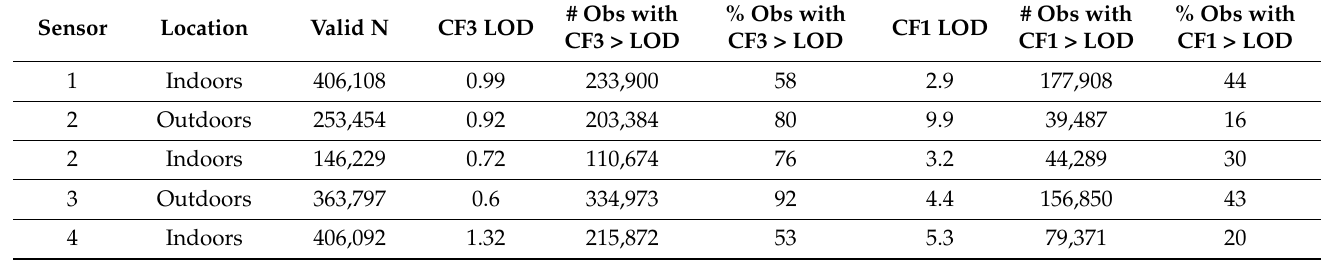
Table 4. PM 2.5 LODs ( µ g/m 3 ) calculated for the ALT-CF3 and Plantower CF1 algorithms. Number and percent of observations greater than the LOD.